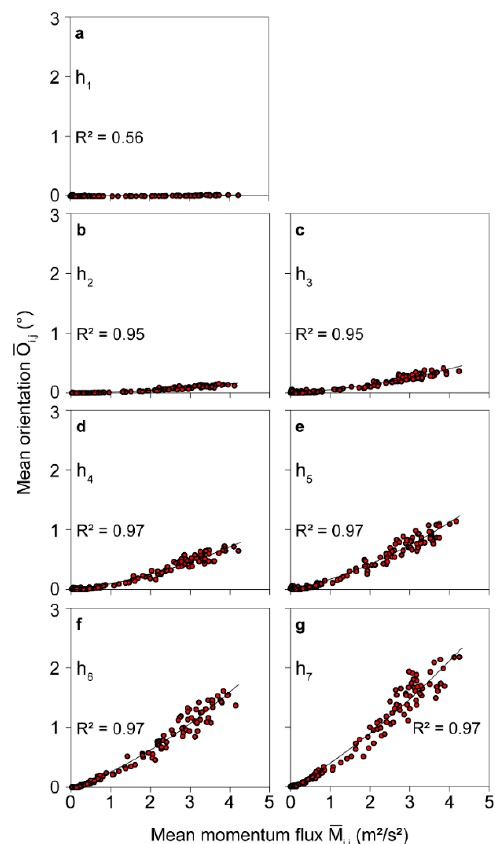
Figure 3. Mean orientation ( O 1,j to O 7,j ) during irregular intervals (j) at measuring heights ( a – g ) h 1 Figure 3. Mean orientation ( 𝑂(cid:3364) (cid:2869),(cid:2920) to 𝑂(cid:3364) (cid:2875),(cid:2920) ) during irregular intervals ( j ) at measuring heights ( a – g ) ℎ (cid:2869) Figure 3. Mean orientation ( 𝑂(cid:3364) (cid:2869),(cid:2920) to 𝑂(cid:3364) (cid:2875),(cid:2920) ) during irregular intervals ( j ) at measuring heights ( a – g ) ℎ (cid:2869) to h 7 plotted against mean momentum flux at canopy top ( M 1,j to M 7,j ) on 30 January 2019. R 2 is the to ℎ (cid:2875) plotted against mean momentum flux at canopy top ( 𝑀(cid:3365) (cid:2869),(cid:2920) to 𝑀(cid:3365) (cid:2875),(cid:2920) ) on 30 January 2019. 𝑅 2 is the to ℎ (cid:2875) plotted against mean momentum flux at canopy top ( 𝑀(cid:3365) (cid:2869),(cid:2920) to 𝑀(cid:3365) (cid:2875),(cid:2920) ) on 30 January 2019. 𝑅 2 is the coe ffi cient of determination. coefficient of determination. coefficient of determination.